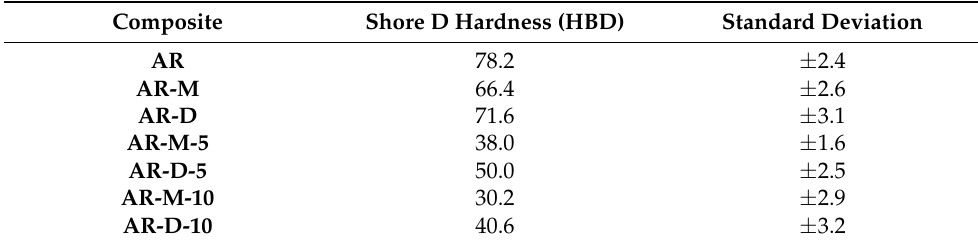
Table 2. Shore D hardness values of AR and the nanocomposites printed in this work. Composite Shore D Hardness (HBD) Standard Deviation AR